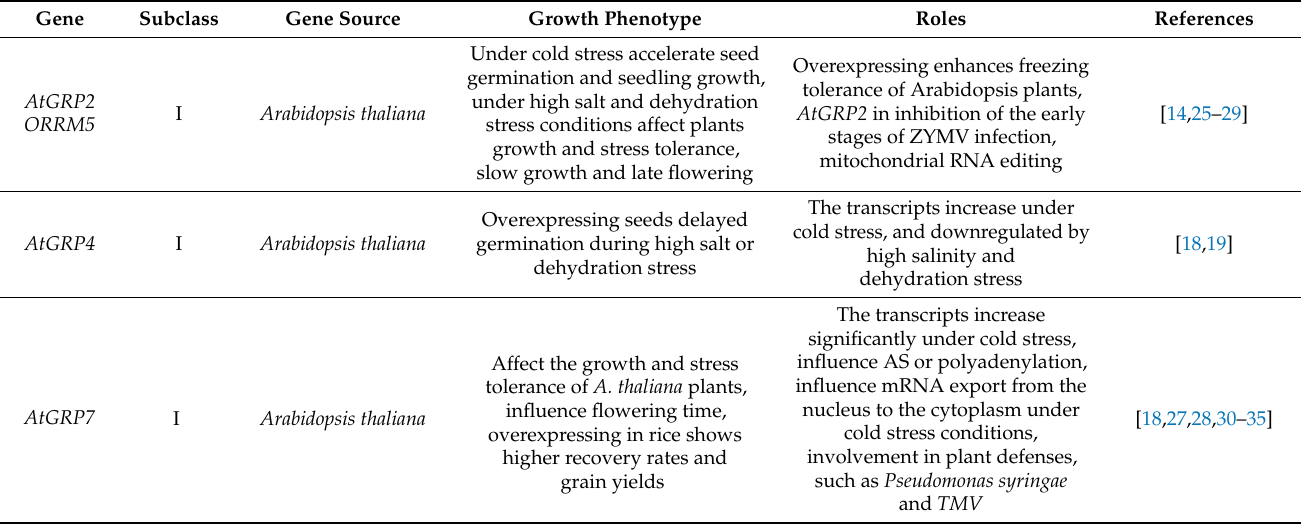
Table 2. Description of the identified plant glycine-rich RNA binding